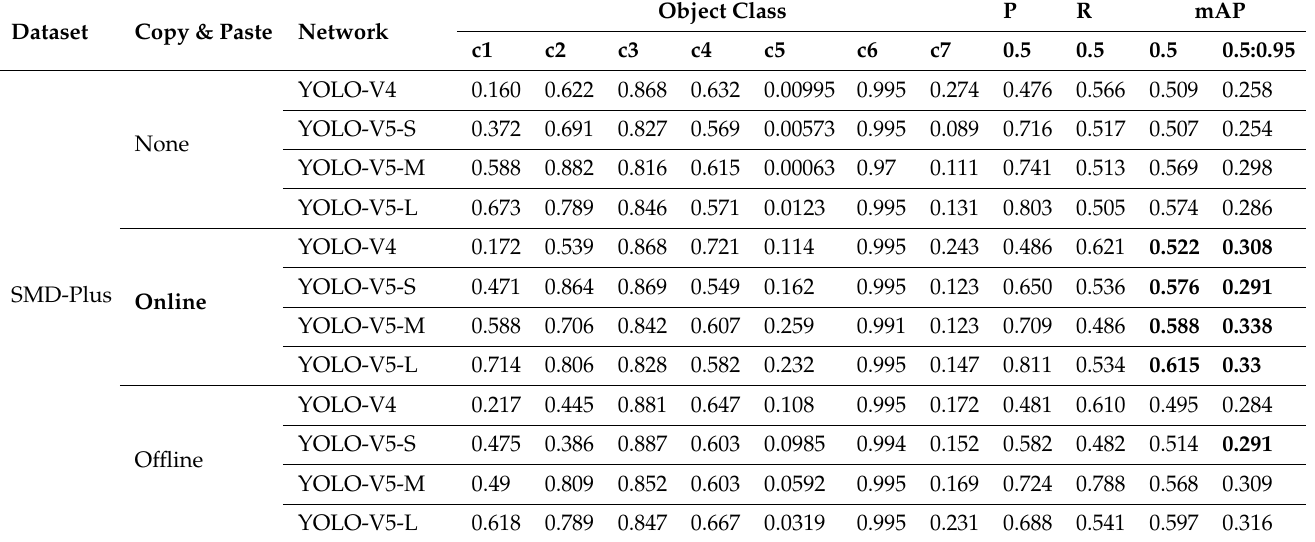
Table 6. Detection-then-classification results for the SMD-Plus dataset: c1: Ferry, c2: Buoy, c3: Vessel_ship, c4: Boat, c5: Kayak, c6: Sail_boat, c7: Others. Columns P and R represent the precision and the recall performance, respectively, for IoU =